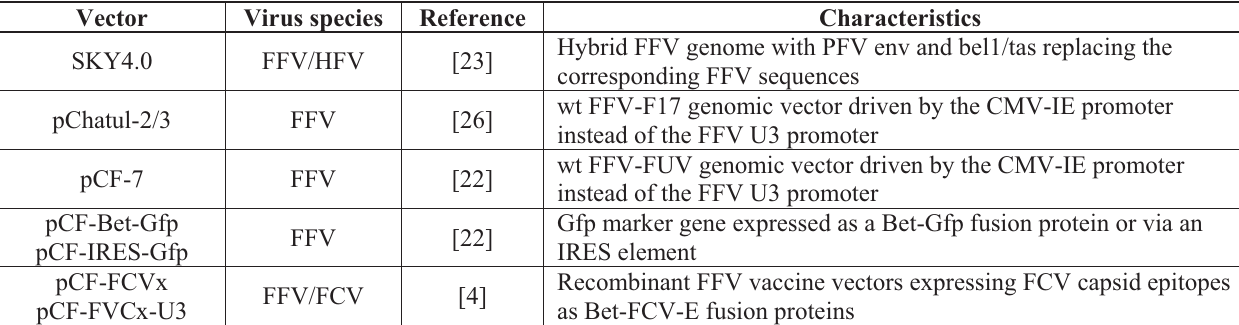
Table 1. Selected replication-competent feline foamy virus (FFV) vectors and their properties. HFV, human foamy virus; PFV, primate foamy virus; CMV-IE, cytomegalovirus